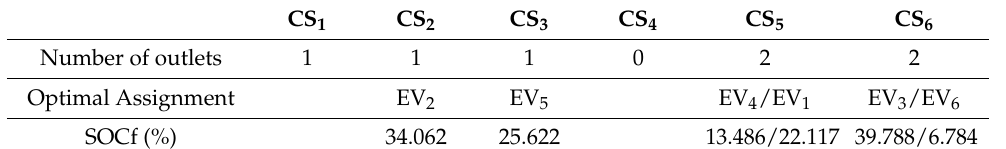
Table 3. Optimal assignment of EVs.